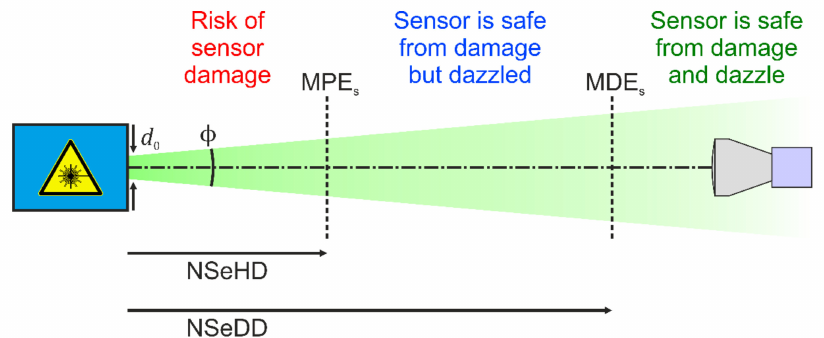
Figure 9. Hazard distances for imaging sensors: Nominal Sensor hazard Distance (NSeHD) and Nominal Sensor Dazzle Distance